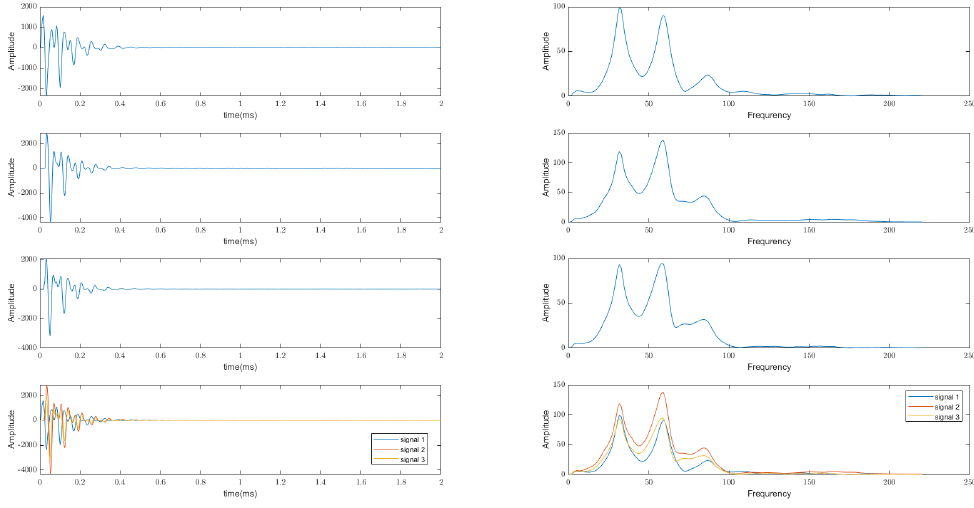
Figure 3. Appearance of the experimental data (first sensor, three experiments).